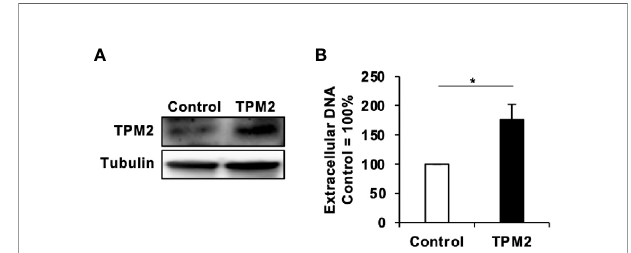
FIGURE 6 | Tropomyosin b chain (TPM2) overexpression increases HBV production. (A) TPM2 expression in TPM2-expressing HepG2-NTCP cells. Overexpression of TPM2 in TPM2-expressing HepG2-NTCP cells was con fi rmed by western blot. Tubulin was used as an internal control. (B) Extracellular HBV DNA. TPM2-expressing HepG2-NTCP cells were infected with HBV and then cultured for 9 days with refreshing the medium every 3 days. HBV DNA in culture supernatants of the cells was measured by real-time PCR. Values are expressed as the mean percentage + S.E. of three independent experiments. * P